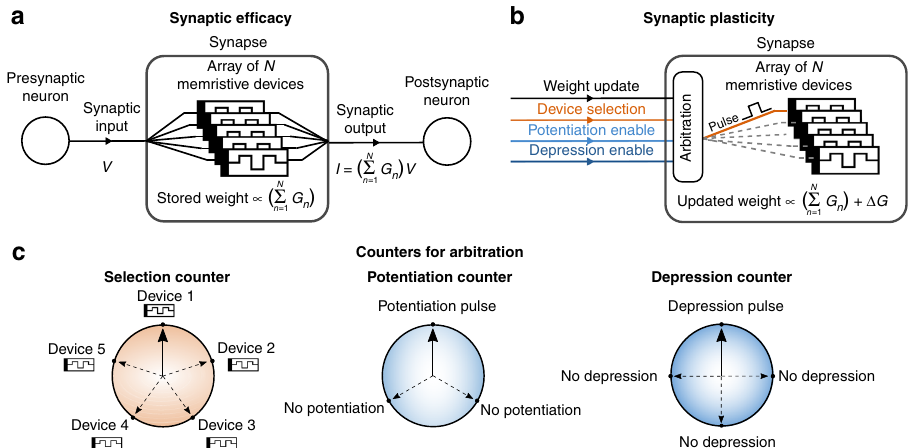
Fig. 1 The multi-memristive synapse concept. a The net synaptic weight of a multi-memristive synapse is represented by the combined conductance P G ð Þ of multiple memristive devices. To realize synaptic ef fi cacy, a read voltage signal, V , is applied to all devices. The resulting current fl owing through n each device is summed up to generate the synaptic output. b To capture synaptic plasticity, only one of the devices is selected at any instance of synaptic update. The synaptic update is induced by altering the conductance of the selected device as dictated by a learning algorithm. This is achieved by applying a suitable programming pulse to the selected device. c A counter-based arbitration scheme is used to select the devices that get programmed to achieve synaptic plasticity. A global selection counter whose maximum value is equal to the number of devices representing a synapse is used. At any instance of synaptic update, the device pointed to by the selection counter is programmed. Subsequently, the selection counter is incremented by a fi xed amount. In addition to the selection counter, independent potentiation and depression counters can serve to control the frequency of the potentiation or